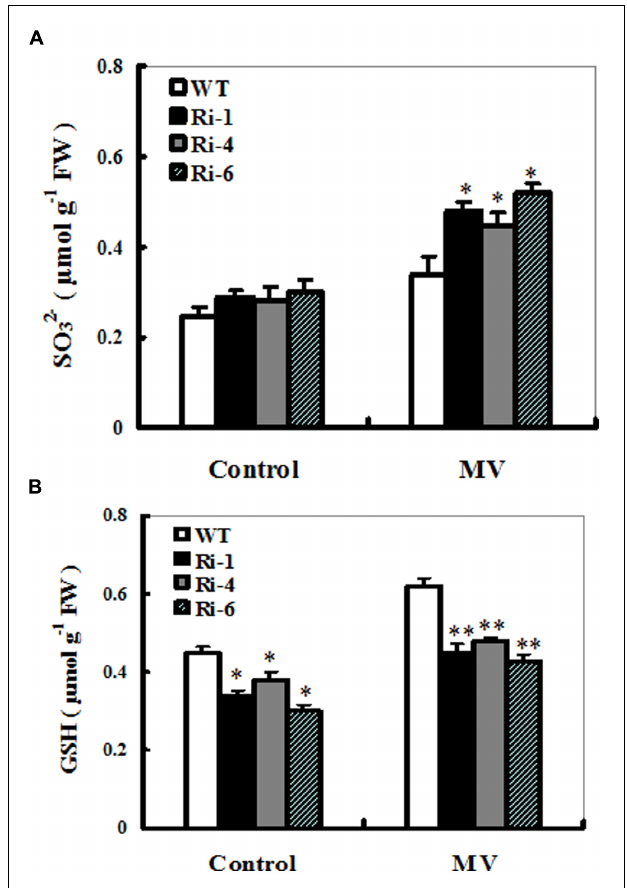
FIGURE 5 | Sulfite and glutathione accumulations in the wild-type and SiR RNAi plants upon MV exposure. Contents of sulfite (A) and glutathione (B) were measured 3 days after MV (20 µ M) spraying. Each experiment was repeated three times. Bar indicates SE. Values are mean ± SE. ∗∗ t -test, with P < 0.01; ∗ t -test, with P <